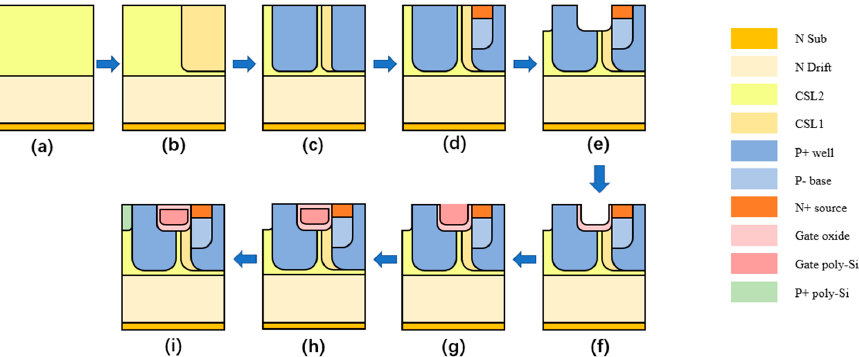
Figure 12. The proposed fabrication process. ( a ) Epitaxial N- drift and CSL1 ( b ) Forming of CSL2 by ion implantation ( c ) Forming of P+ well by ion implantation ( d ) Forming of P- base and N+ source by double ion implantation ( e ) Annealing, trench gate region and HJD region ( f ) Thermal oxidation to form gate oxide ( g ) Depositing of gate poly-silicon ( h ) Depositing of gate oxide ( i ) Depositing of P+-doped poly-silicon of HJD region. P+-doped poly-silicon of HJD